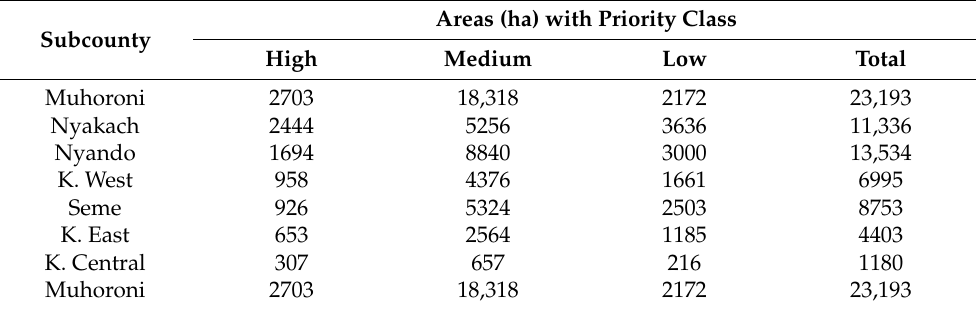
Table 8. The land availability at different priority classes for tree and hedgerow plantations in Kisumu, Kenya.